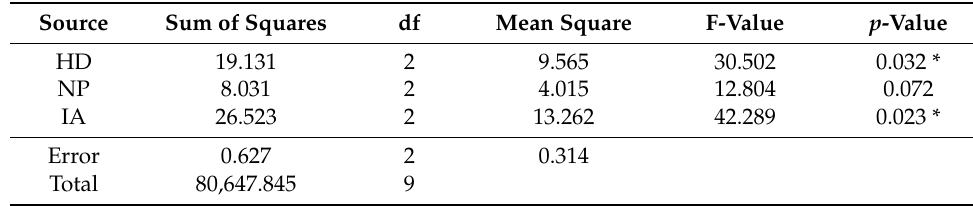
Table 4. ANOVA results for adsorption effect.